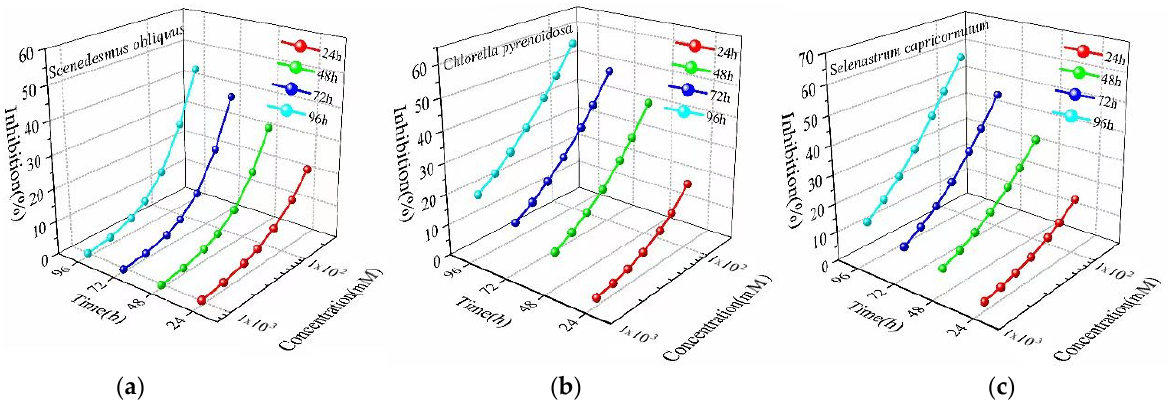
Figure 1. Concentration–effect curves of S. obliquus ( a ), C. pyrenoidosa ( b ) and S. capricornutum ( c ) at different durations of Cd exposure.